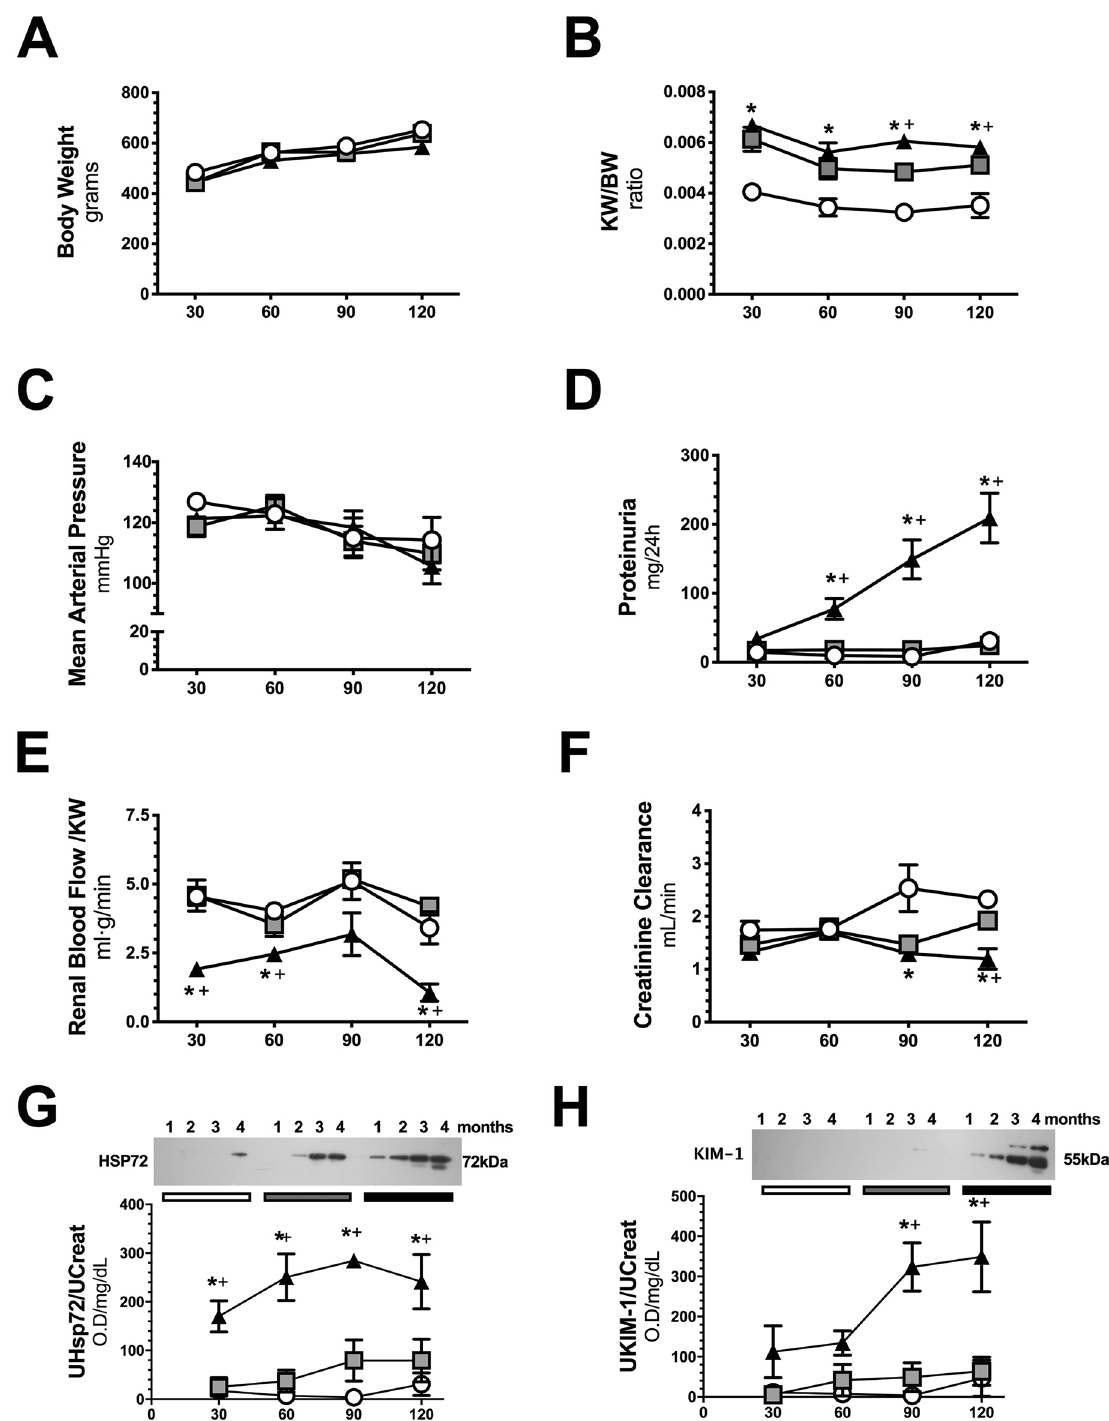
Figure 2. Follow-up of renal function in the AKI to CKD transition. ( A ) Body weight, ( B ) Ratio kidney weight/body weight, ( C ) Mean arterial Pressure, ( D ) Proteinuria, ( E ) Renal blood flow / kidney weight, ( F ) Creatinine clearance, ( G ) Urinary HSP72 corrected by urinary creatinine, and ( H ) Urinary KIM-1 corrected by urinary creatinine, including representative cropped blots, along the follow-up. Data are represented as the mean ± SE. n = 4, 4, and 5 for the S, UNx, and IR + UNx groups in each studied period: 30, 60, 90, and 120 days post-ischemia. White circles represent the S, gray squares represent UNx and black triangles represent IR + UNx groups. The one-way analysis of variance (ANOVA) was used to determine statistical differences, using the Bonferroni correction for multiple comparisons. * p < 0.05 versus S group and + p < 0.05 versus UNx group in their respective period. Full-length blots are presented in Supplementary Figs. 4 and